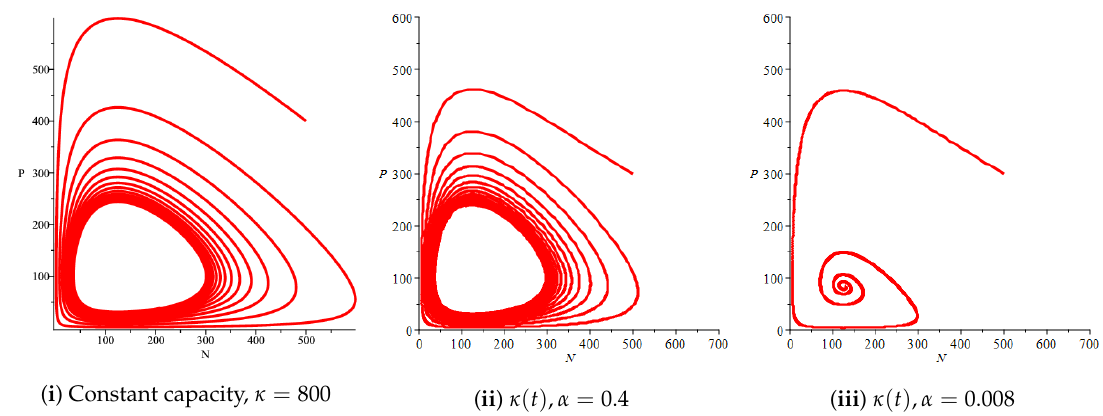
Figure 6. Effect of the logistic variable carrying capacity on the phase space of the prey–predator model with Holling type II functional response for κ 1 = 300, κ 2 = 500, r = c = 0.25, a = b = 0.0025, γ = 0.002.